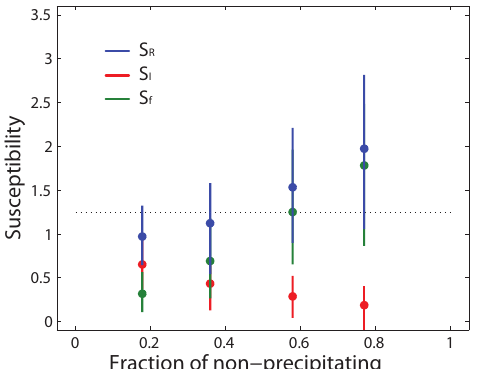
Fig. A6. The precipitation susceptibility S R (blue), susceptibility of drizzle intensity S I (red), and susceptibility of drizzle fraction S f (green) with increasing threshold value, calculated using the TLD method. Instead of the ratio between the threshold and mean pre- cipitation rate, the average fraction of non-precipitating points at each threshold is used for the abscissa. The dotted line represents the underlying β